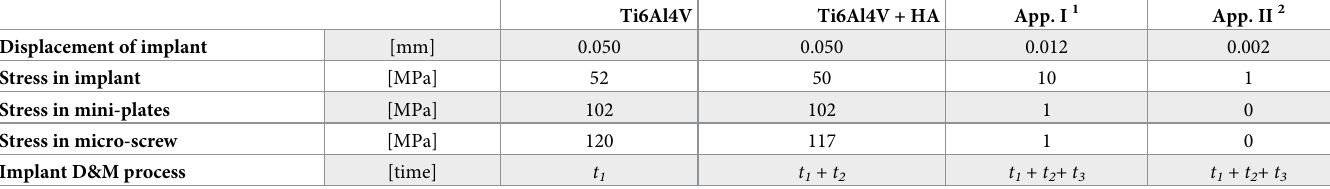
Table 2. A comparison of results obtained for a small-sized cranial Ti6Al4V implant without and with HA